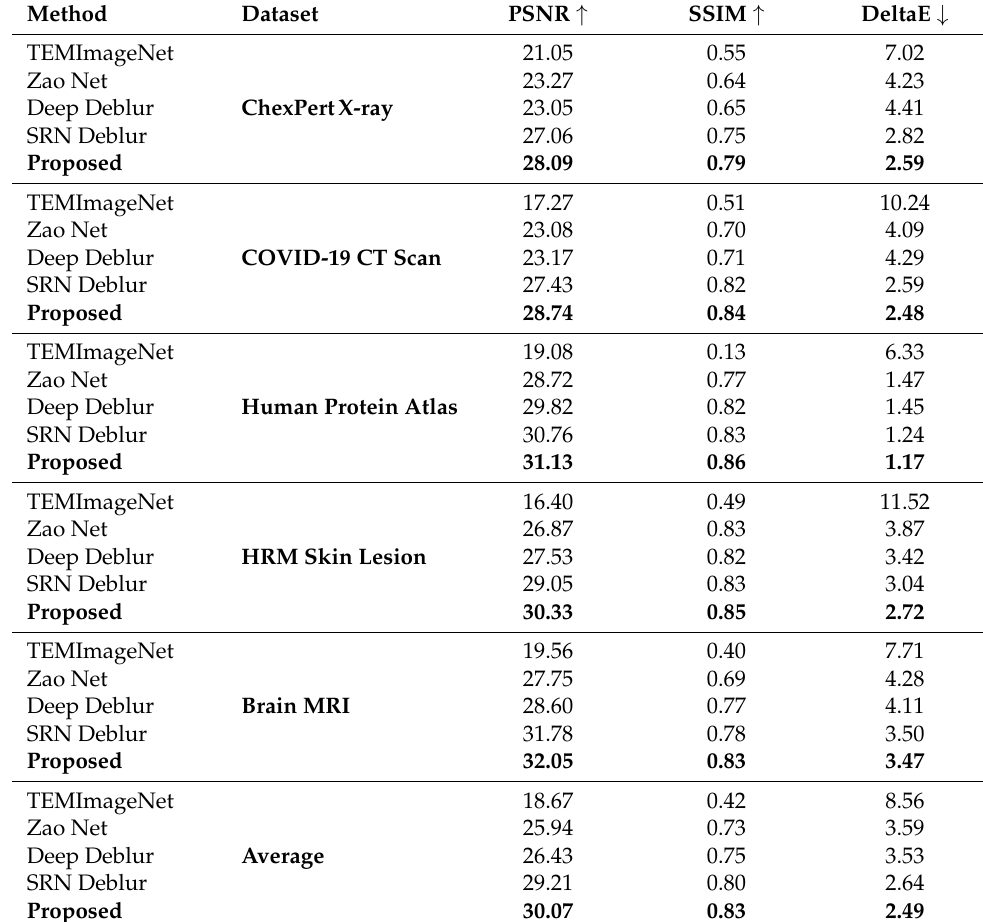
Table 2. Quantitative comparison between deblurring methods in different medical image datasets. The proposed method outperforms existing methods in all evaluating